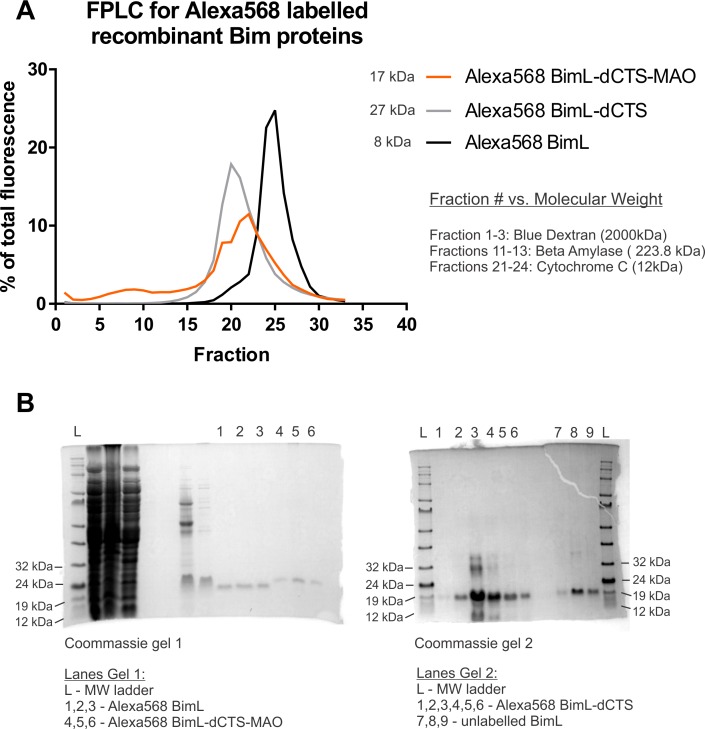
Recombinant BimL proteins do not aggregate and are the expected moelcular weights.(A) Alexa568-labeled recombinant Bim proteins are not aggregating. FPLC data demonstrating that recombinant proteins elute as single peaks in fractions of low molecular weight (calculations found in source data). (B) SDS-PAGE Indicates Alexa568-labeled Bim proteins migrate at positions that correspond to the correct molecular weight. Gel1 indicates that Alexa568 BimL-dCTS-MAO (Lanes 4,5,6) is slightly larger than Alexa568 BimL (Lanes 1,2,3) as suggested by their molecular weights of 21.38 kDa and 19.62 kDa, respectively. Gel two indicates Alexa568 BimL-dCTS (Lanes 1,2,3,4,5,6), molecular weight of 17.25 kDa is slightly smaller than unlabeled BimL (Lanes 7,8,9) (molecular weight of 18.74 kDa).Figure 7—figure supplement 2—source data 1.FPLC source data demonstrating recombinant BimL proteins do not aggregate.